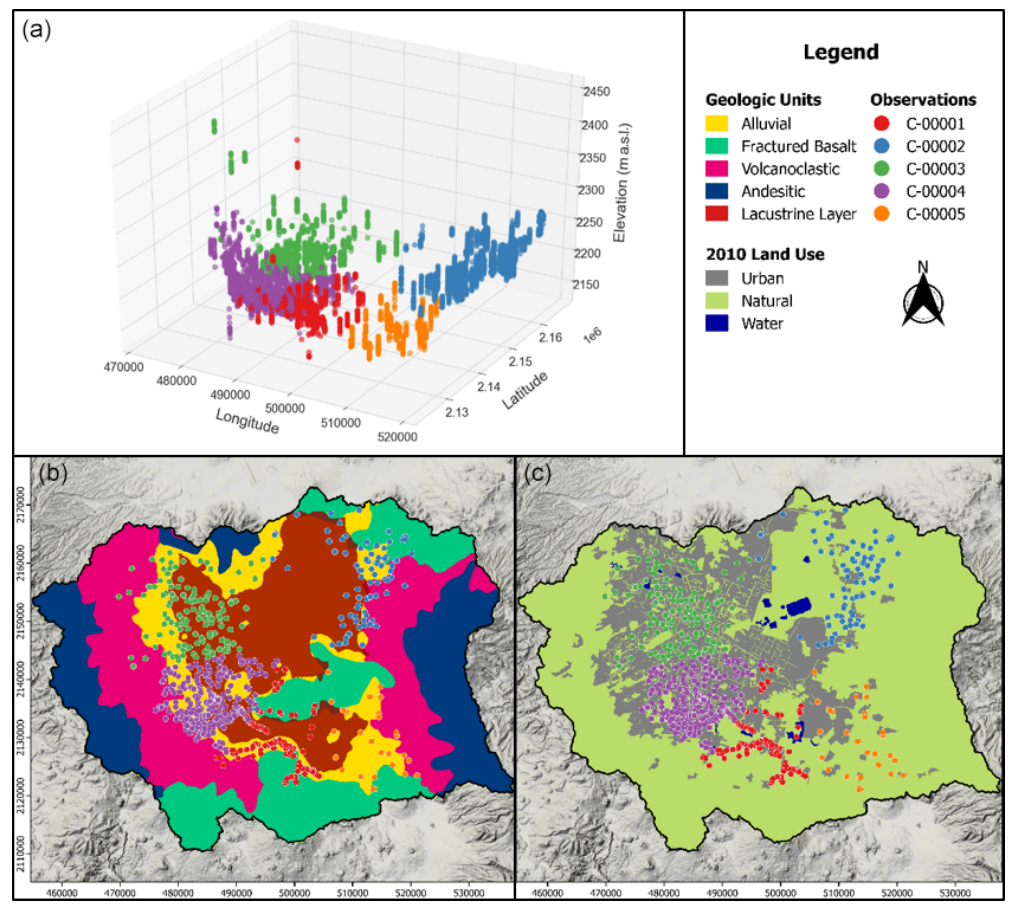
Figure 2. (a) A 3-dimensional visualization of the five clusters of observations used in this study. (b) Observation clusters shown with the geologic formations within the model area. (c) Observation clusters shown with the land use types for the model period covering